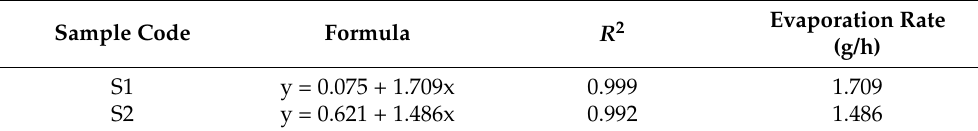
Figure 12. Evaluation of water evaporation rate of the sample S1 and S2. Table 7. Evaporation rate of the sample S1 and